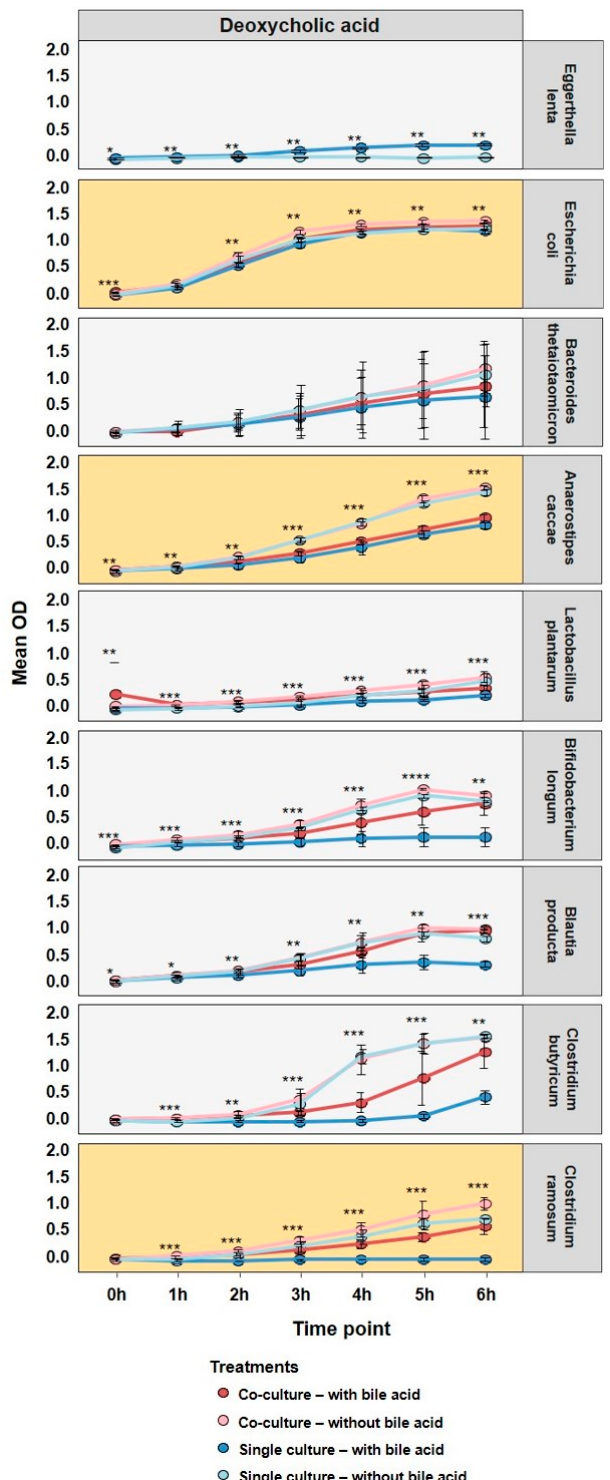
Figure 1. Growth of SIHUMIx species in single and co-culture with E. lenta with treatment 200 µM DCA. For each experiment, six replicates were analyzed and the line represents the mean. Strains are ranked according to increasing inhibition of growth when stressed with DCA. Error bars are standard deviations. Statistical significance was determined using ANOVA analysis, * p < 0.05, ** p < 0.01, *** p < 0.005, **** p < 0.001.